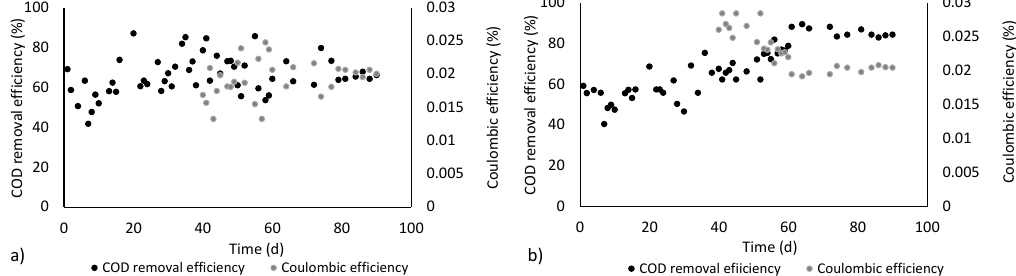
Figure 3. Chemical oxygen demand (COD) removal and coulombic efficiency in ( a ) MFC1 and ( b ) MFC2.